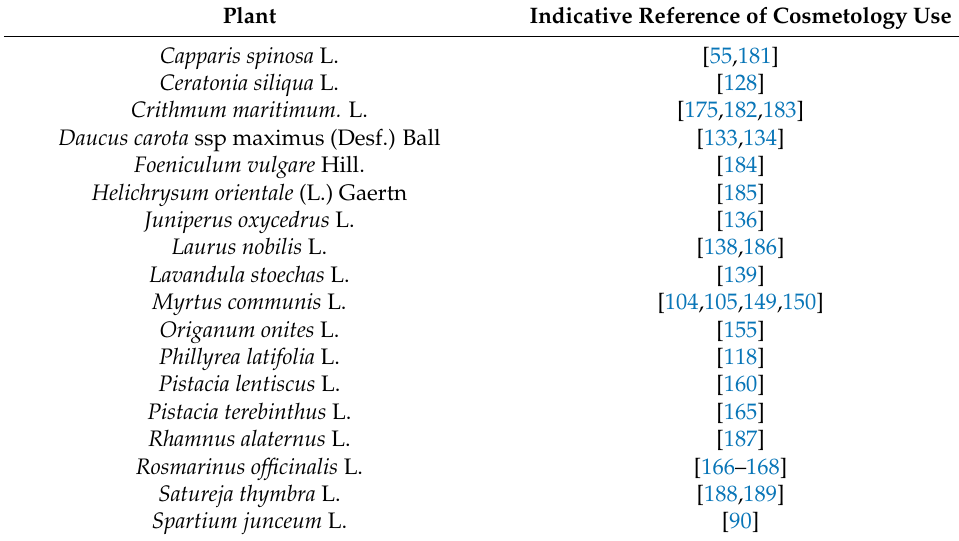
Table 5. Mediterranean plants in cosmetology in the literature. Plant Indicative Reference of Cosmetology